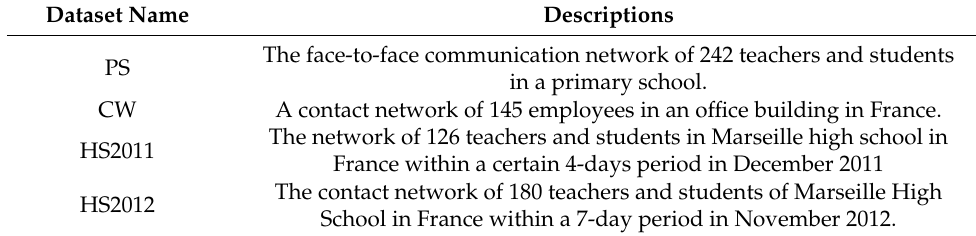
Table 2. Descriptions of